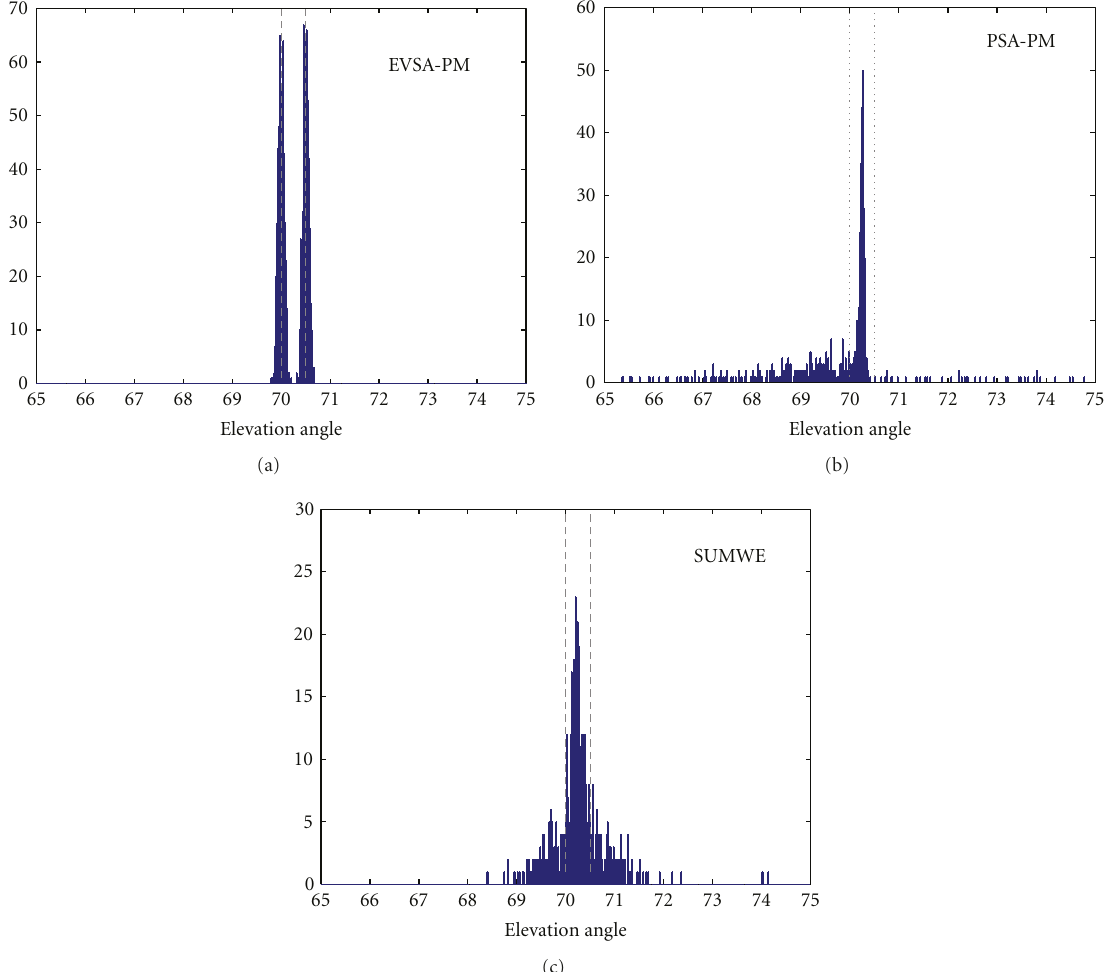
Figure 5: The histogram of the estimated elevation using the three methods. (a) EVSA-PM; (b) PSA-PM; (c)